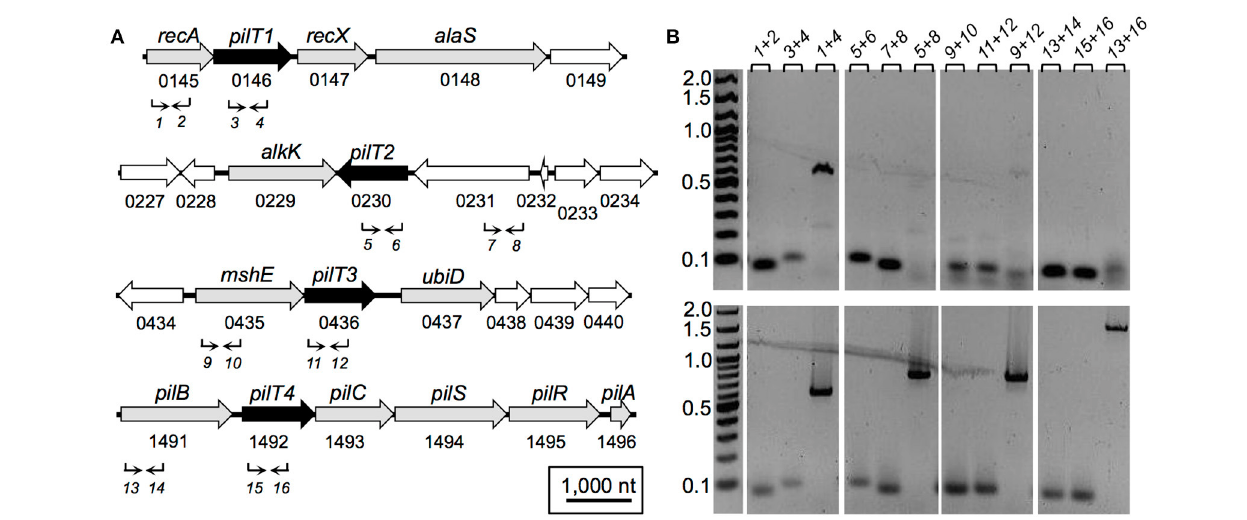
FIGURE 2 | Genetic (A) and transcriptional (B) organization of pilT genes in G. sulfurreducens . (A) Schematic view of the genomic region containing each of the four pilT genes (labeled 1–4, black arrows) and neighboring ORFs (white arrows, hypothetical gene; gray arrows, annotated function). Also shown are gene designations (gene name and ORF number, above and below, respectively) and PCR primers ( 1 – 16 ; Table 2 ) and direction of amplification (arrows). (B) Agarose gels showing cDNA amplified from each pilT gene region and neighboring genes (top panels) in reference to products amplified from genomic DNA controls (bottom panels). PCR-amplifications used primer sets 1 – 16 , as indicated in (A) and listed on top of the gel panels in (B) . Lanes, gene target (primer combination): recA ( 1 + 2 ), pilT1 ( 3 + 4 ), recA-pilT1 ( 1 + 4 ), pilT2 ( 5 + 6 ), GSU0231 ( 7 + 8 ), pilT2-GSU0231 ( 5 + 8 ), mshE ( 9 + 10 ), pilT3 ( 11 + 12 ), mshE-pilT3 ( 9 + 12 ), pilB ( 13 + 14 ), pilT4 ( 15 + 16 ), pilB-pilT4 ( 13 + 16